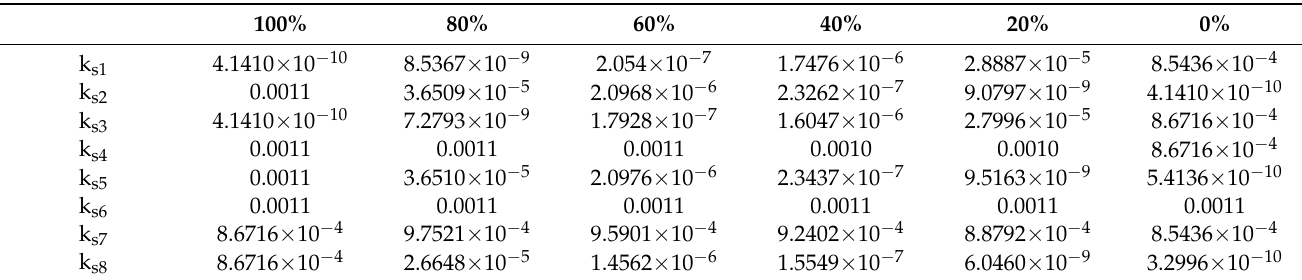
Table 1. Reaction rates for each effectiveness value of azobenzene.